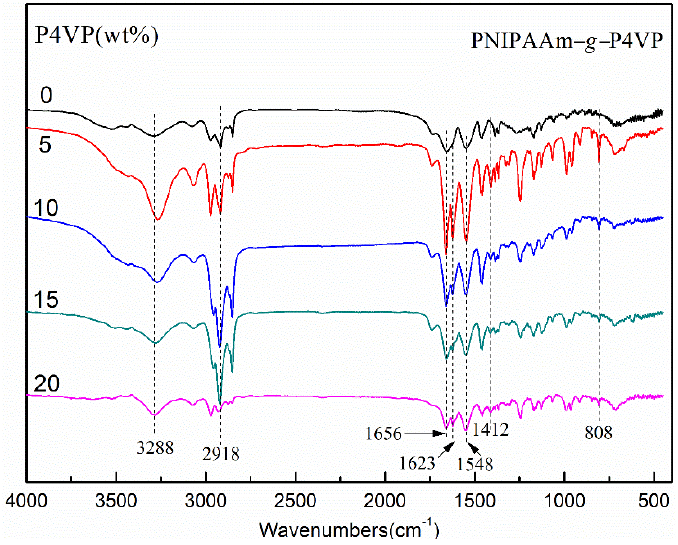
Figure 2. FTIR spectra of PNIPAAm and PNIPAAm − g − P4VP.